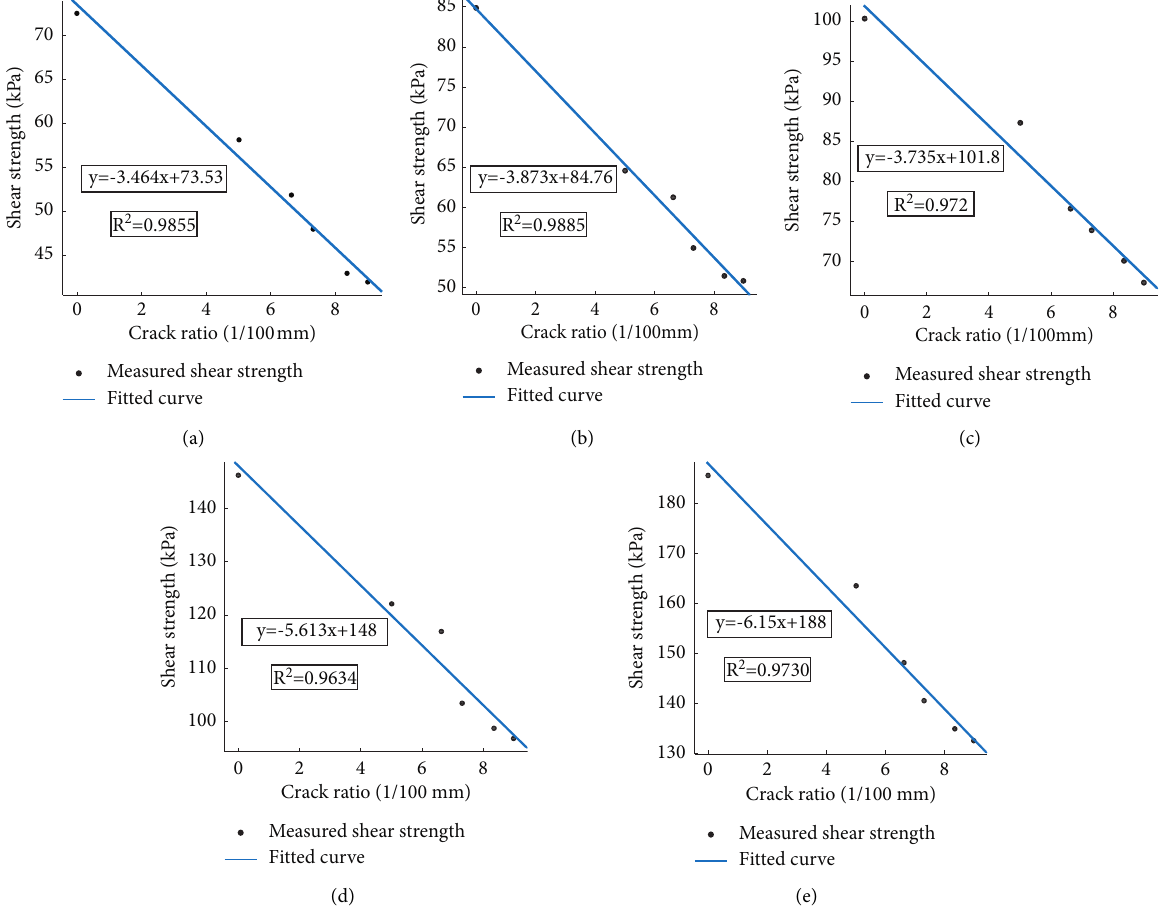
Figure 8: Relationship between crack ratio and shear strength of Chengdu expansive soil under different vertical pressures: (a) 25kPa; (b) 50kPa; (c) 100kPa; (d) 200kPa; (e) 300kPa.